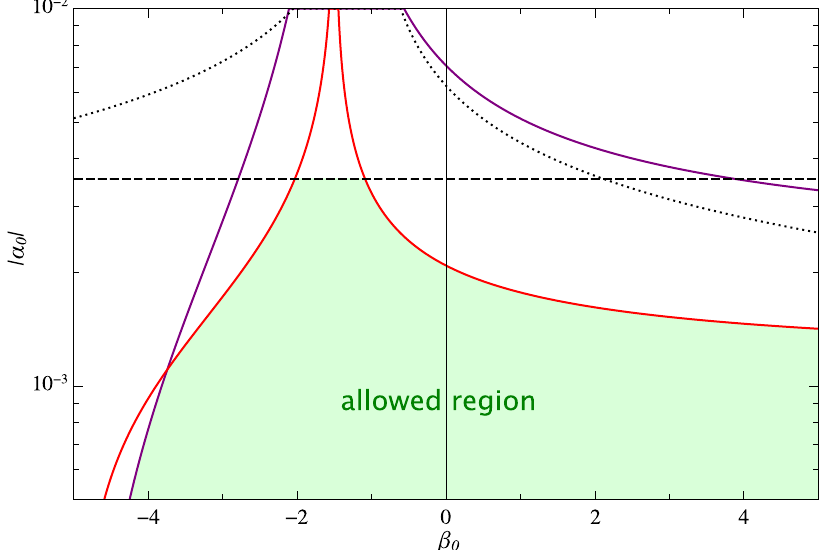
Figure 6. Constraints in the α 0 - β 0 plane of DEF gravity by the triple system (red), dipolar radiation test with PSR J1738 + 0333 [Section 5.1] (purple), Cassini [30] (black, dashed), and SEP test with MESSENGER [120] (black, dotted). The region above a curve is excluded by the corresponding experiment. Pulsar constraints are based on the rather stiff EOS BSk22 [99], which generally gives conservative limits (see [116] for a discussion, and a more EOS-agnostic approach). The β 0 = 0 line corresponds to Jordan-Fierz-Brans-Dicke